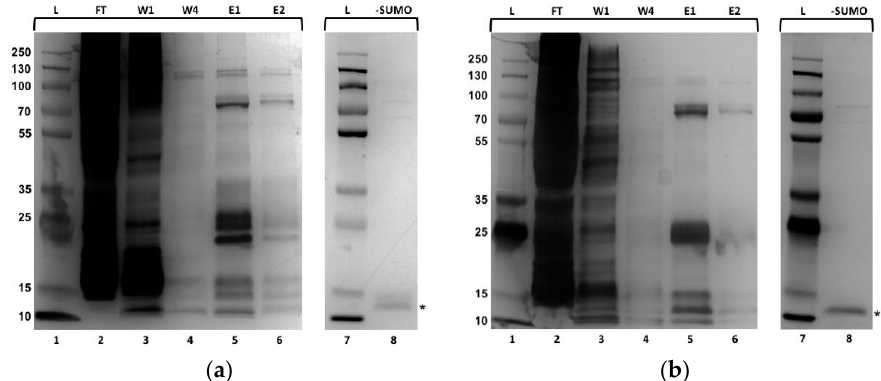
Figure 2. Isolation of recombinant black widow CRP1 and CRP4 from E. coli crude extract. SDS-PAGE analysis of purified CRP1 and CRP4 after affinity chromatography using a Ni-NTA agarose resin. Ubiquitin-like protease (ULP1) was used to remove the 10×His-SUMO tags from purified 10×His-SUMO-CRP1 and 10×His-SUMO-CRP4. Proteins were visualized using silver staining. FT = flow through; W1 and W4 = wash 1 and 4; E = elution 1 and 2; L = protein ladder in kDa; -SUMO = removal of tag. Asterisks represent cysteine-rich proteins (CRPs) lacking tags. ( a ) CRP1; ( b )